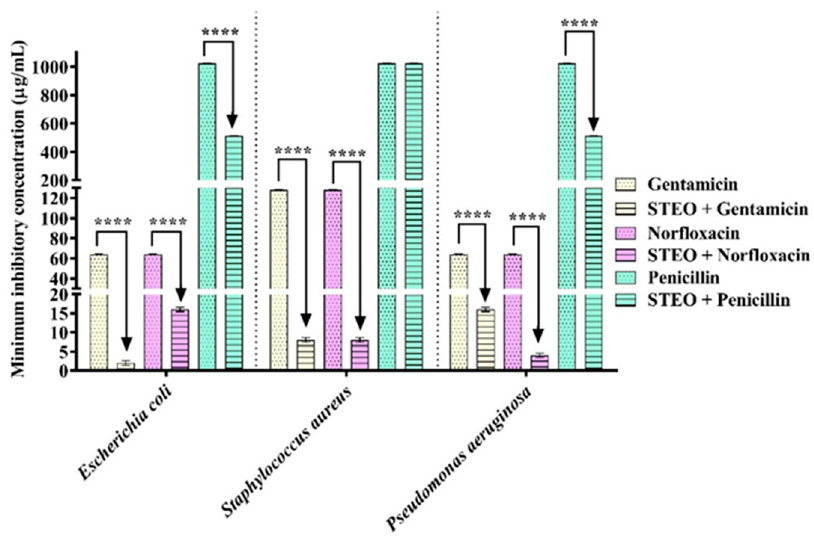
Figure 1. Antibiotic-enhancing effect of Schinus terebinthifolius essential oil (STEO) against MDR strains. **** ( p < 0.0001).